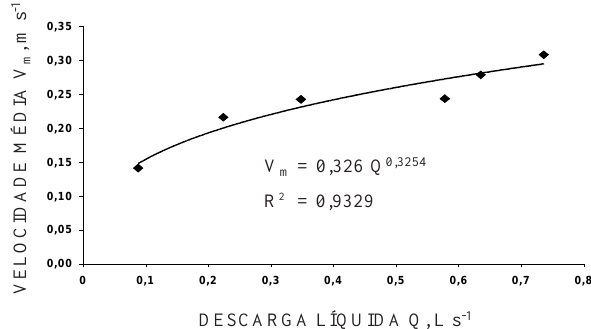
Figura 1. Relação potencial da velocidade média do escoamento com as descargas líquidas médias, obtidas com a aplicação dos fluxos extras ao escoamento superficial gerado pela chuva simulada, em sulcos pré-formados em solo franco-argilo-arenoso recém-preparado.